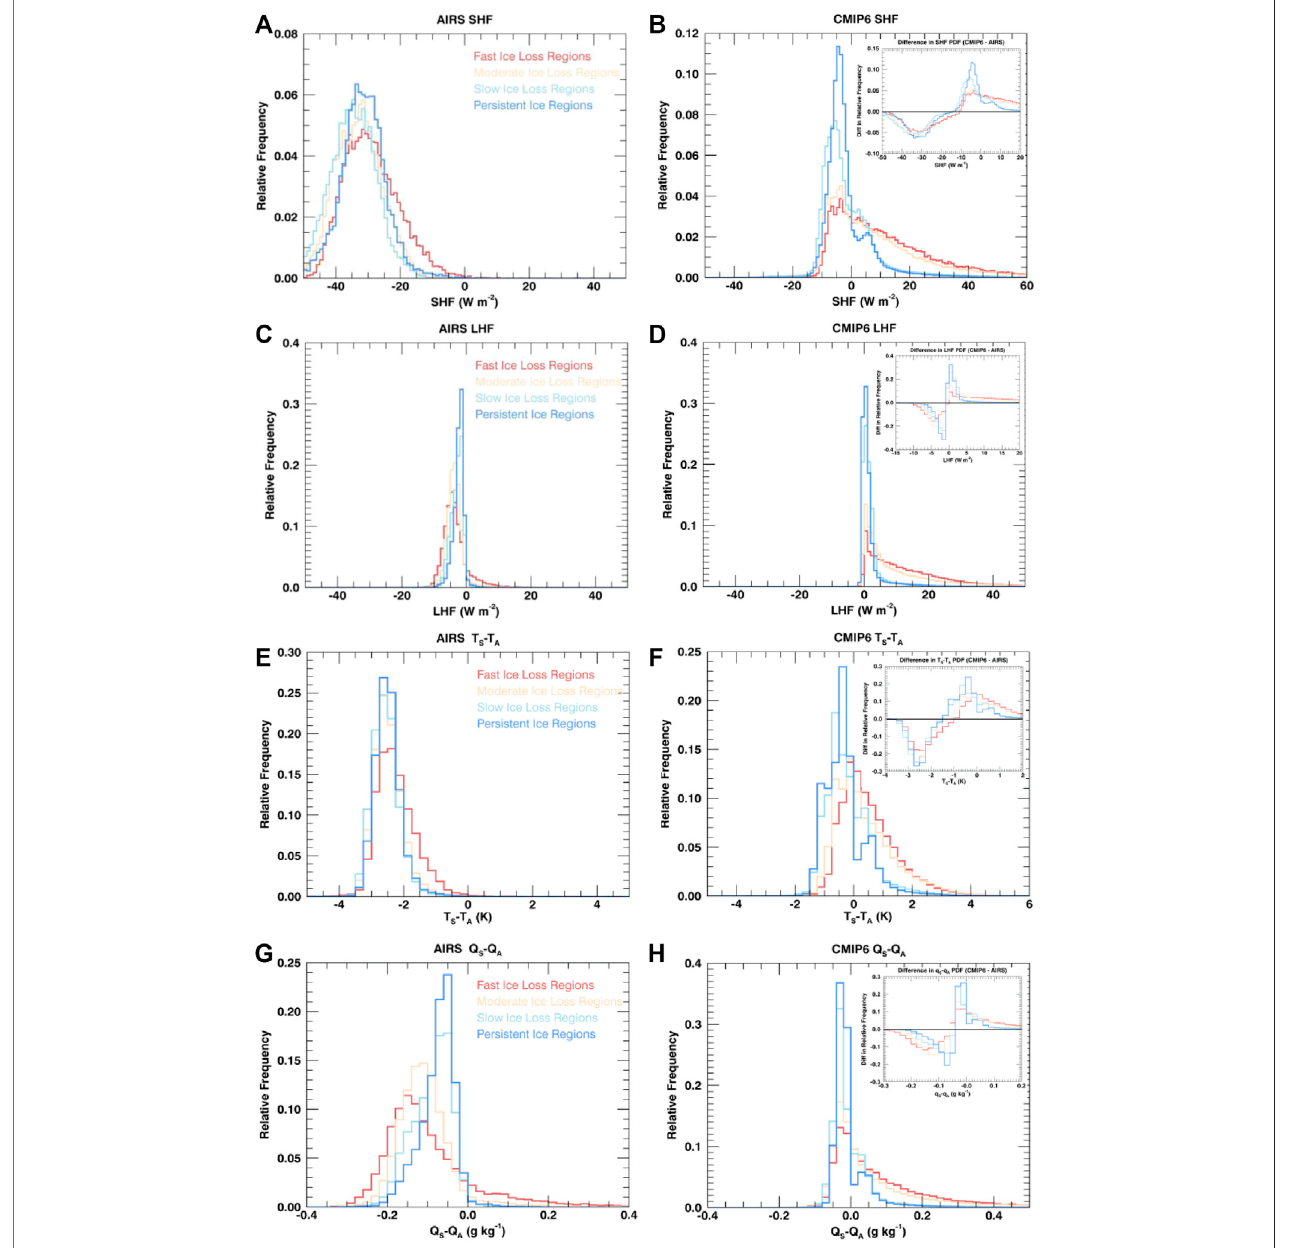
FIGURE 5 | PDFs of surface turbulent fl uxes and surface-air temperature and moisture gradients for AIRS (A,C,E,G) and CMIP6 (B,D,F,H) for the four ice loss regimes for the Arctic winter (ONDJ). Insets represent difference plots (CMIP6 — AIRS).